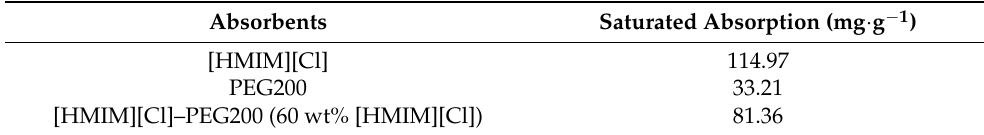
Table 1. Saturation absorption of DCM and benzene mixed gas by